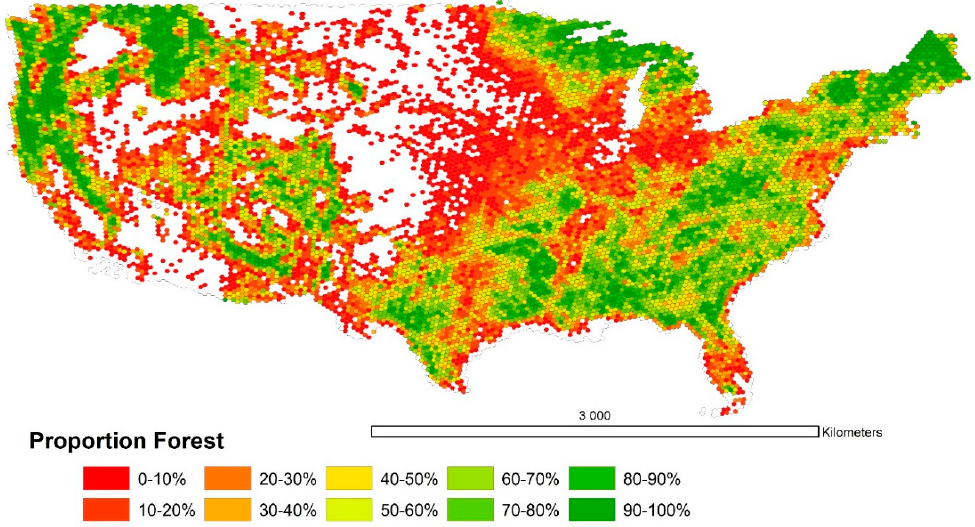
Figure 3. FIA hex-level estimates of the proportion of forest.